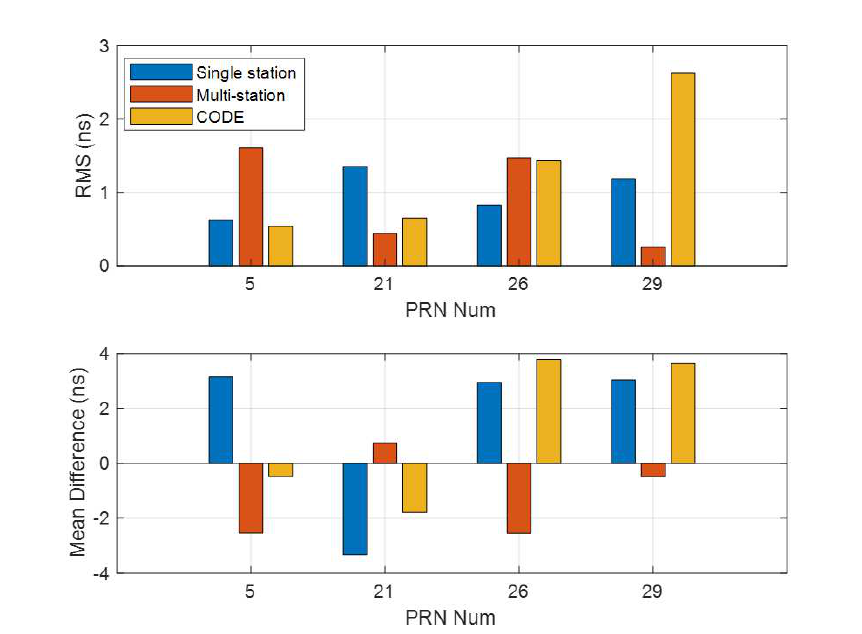
Figure 9. RMS ( top plot) and mean difference ( bottom plot) between correlator spacing flexible receiver estimated satellite DCBs and multi-station estimated DCBs, single-station estimated DCBs, and CODE products for 21:19–21:34, 16 August